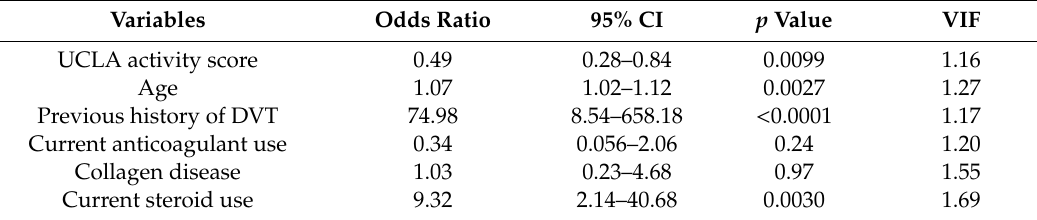
Table 7. Multivariate logistic regression analysis using two parameters reaching p < 0.05 in univariate testing with the UCLA activity score as a representative clinical measurement.